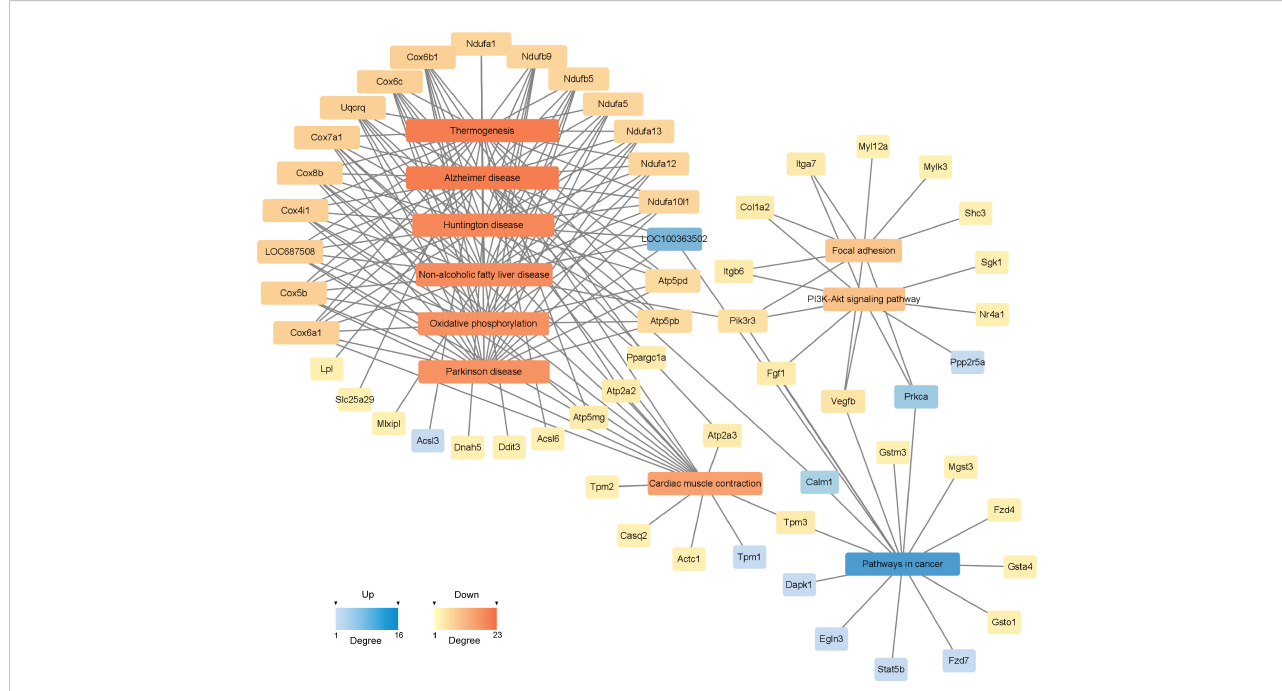
FIGURE 5 KEGG Pathway-act-network of DEGs. The links and overlaps among dif-mRNAs within top 10 signi fi cant enriched KEGG pathway terms. The color and size of each section were both quanti fi ed corresponding to the node connections (degree). Blue sections represent up-regulated mRNAs/pathways. Orange sections represent down-regulated mRNAs/pathway.